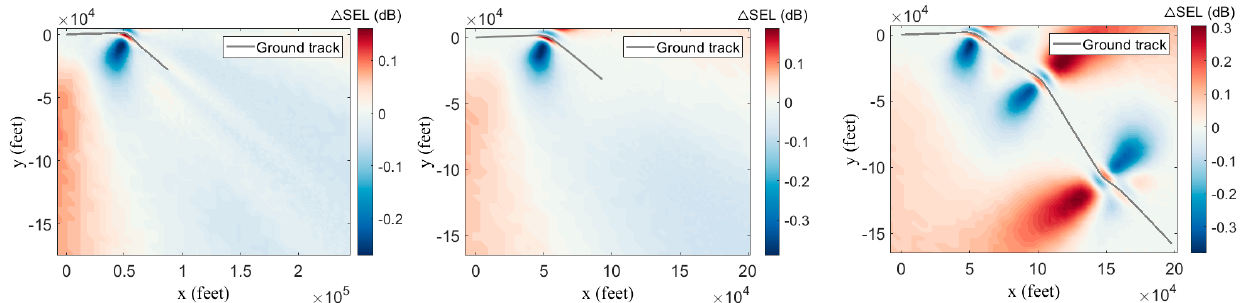
Figure A11. Various aircraft departing from HKIA. Difference in the noise impact (SEL) generated by flights AD1 (left), BD4 (center) and BD5 (right), due to the incorporation of bank angle effect.